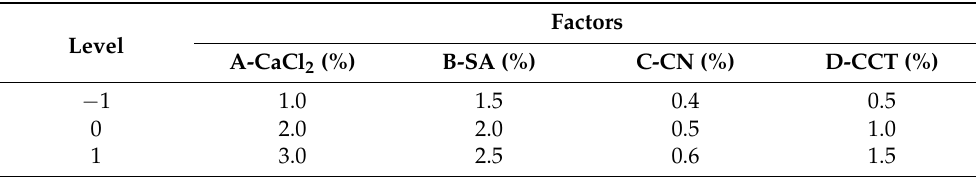
Table 1. Coded values and corresponding actual values of the optimization parameters used in response surface